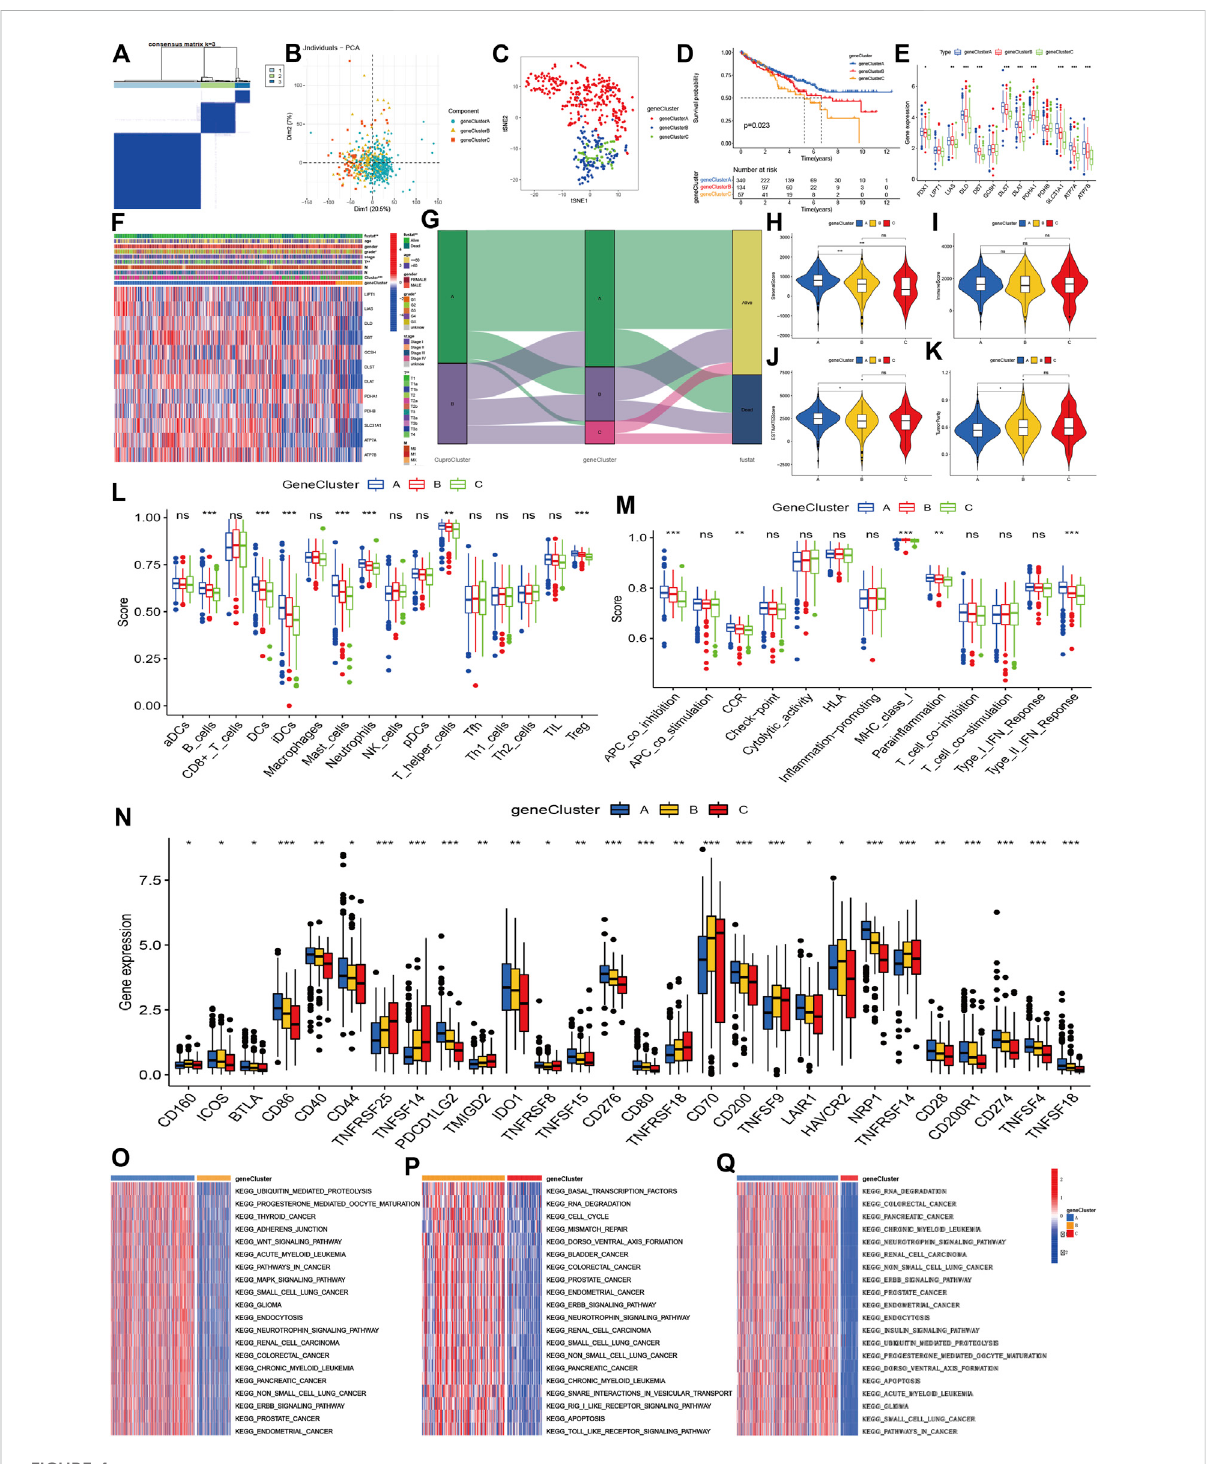
Molecular clustering based on differentially expressed genes between two cuproptosis subtypes. (A) : The consensus matrix identi fi ed the optimal gene clusters. (B,C) : PCA and tSEN identi fi ed three gene clusters. (D) : Kaplan-Meier survival curves of gene clusters. (E,F) : Correlations of geneclusterswithclinicalcharacteristicsandexpressionofcuproptosisregulators. (G) :Associationbetweencuproptosisclusters,geneclusters,and prognosis. (H – K) :stromalandimmune estimate scores, and tumorpurity across threegene clusters. (L,M) :Immune cells andlevels offunction ofthreegeneclusters. (N) :Expressionofimmune-relatedcheckpointgenesamongthreegroups. (O – Q) :Differentiallyexpressedsignalingpathways among three gene